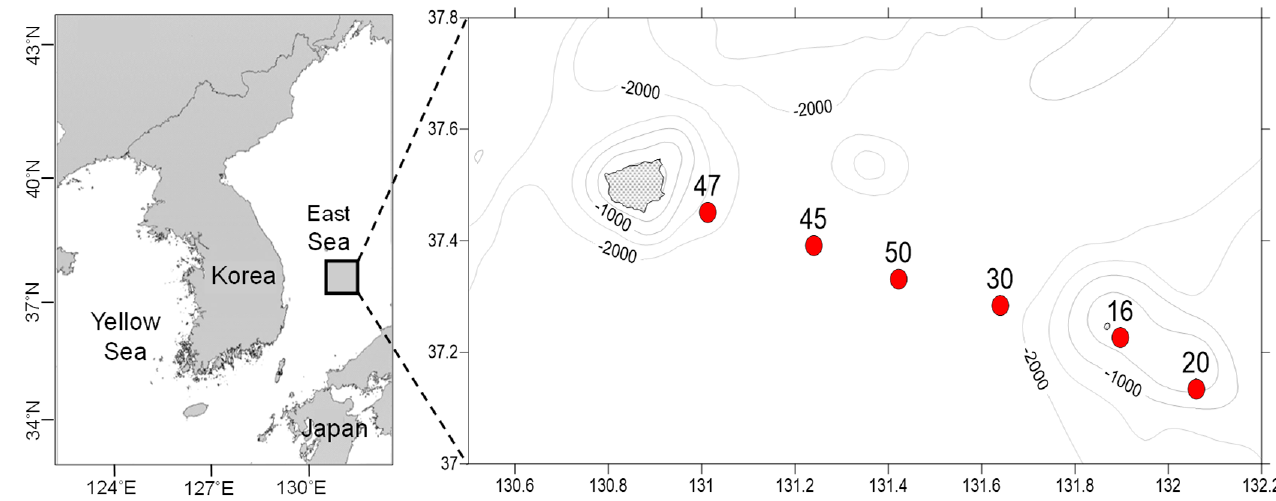
Figure 1. Sampling area in the Ulleung Basin.